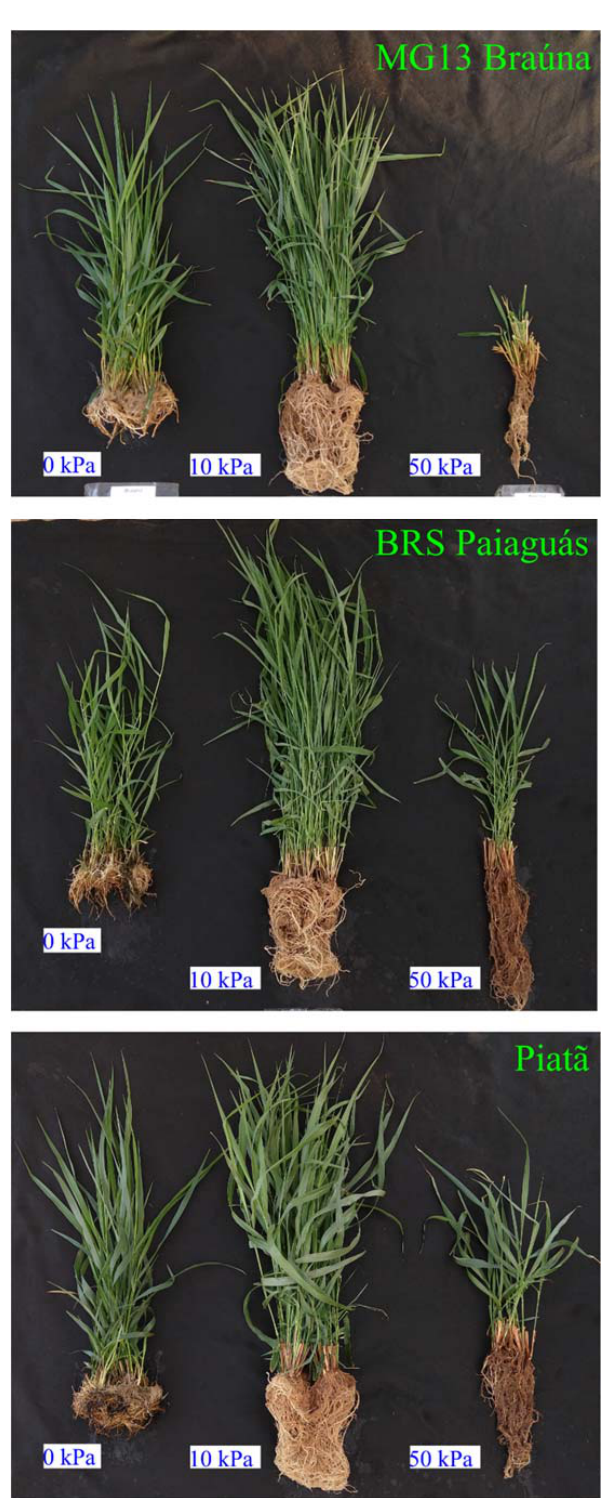
Figure 8. Root development of Brachiaria brizantha cultivars (MG13 Braúna, BRS Paiaguás, and Piatã) at soil water pressure head |h| 0, 10, and 50 kPa on the 100 DAE (third cut).